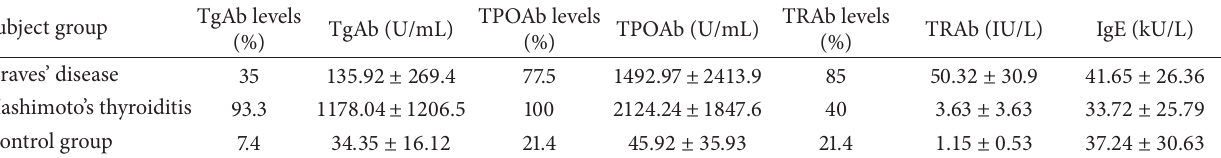
Table 2: Prevalence of positive TRAb levels and elevated IgE levels in various thyroid